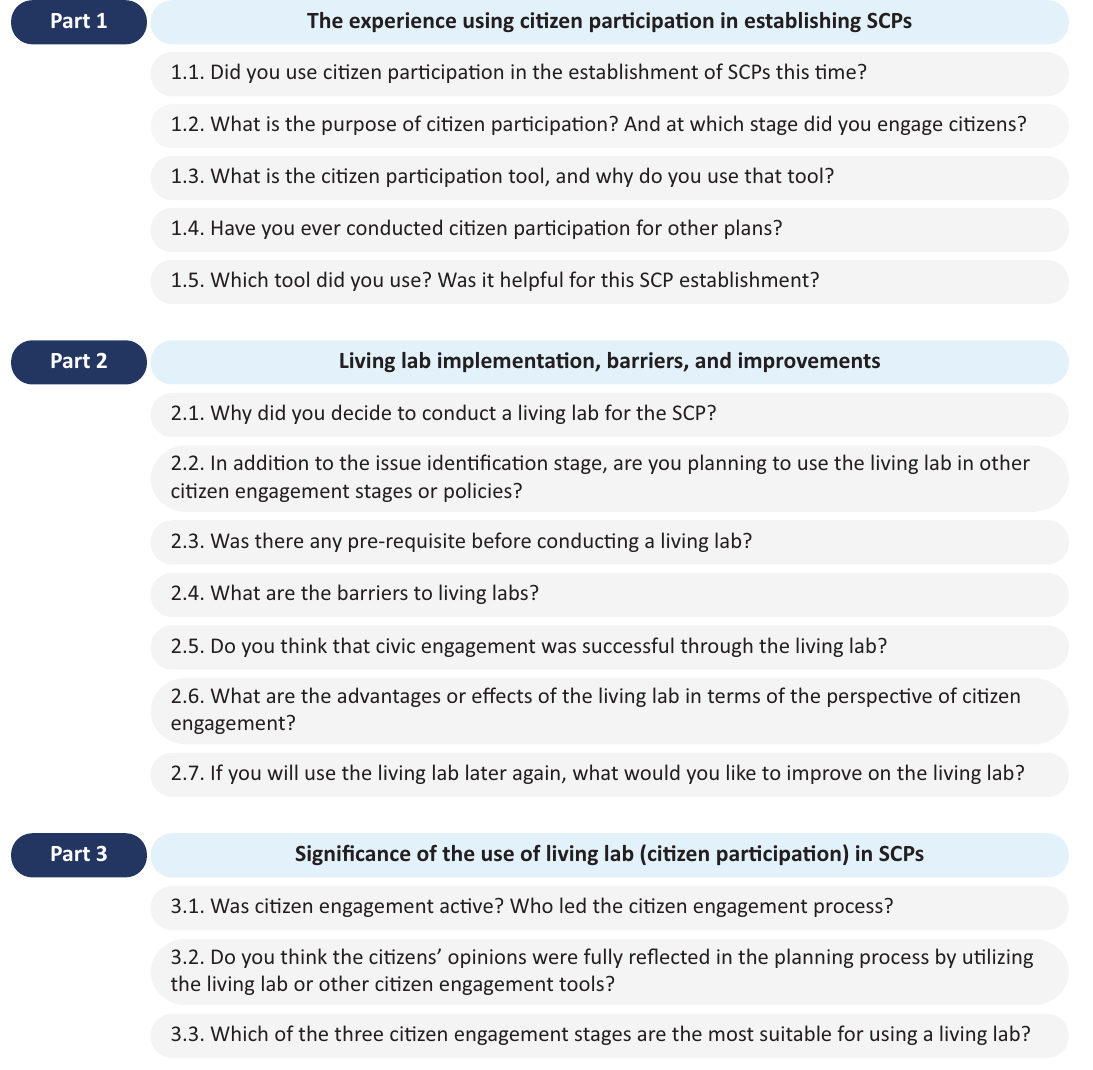
Figure 2. Semi‐structured interview